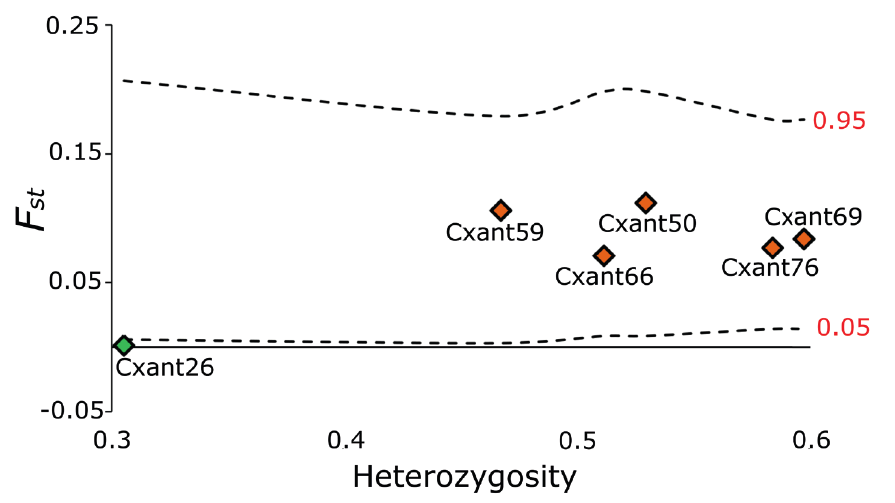
Figure 5. Plot of heterozygosity against F estimations for all ST nuclear microsatellite loci employed in this study. Dashed lines denoted 5 and 95% confi dence